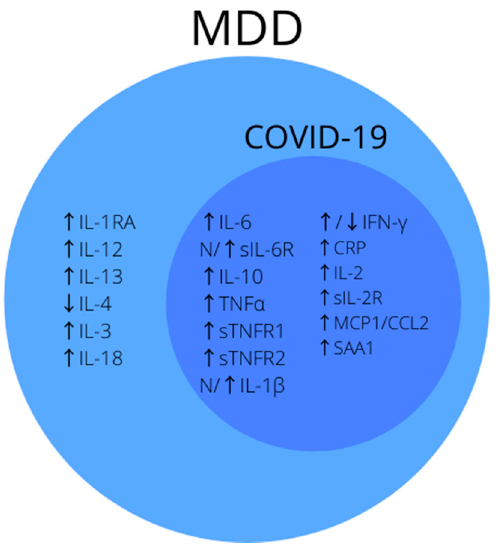
Figure 1. Summary of the most common inflammatory biomarkers of MDD. Note that biomarkers inside dark-blue circle coincide with markers of disturbed homeostasis in COVID-19. Abbrevia-